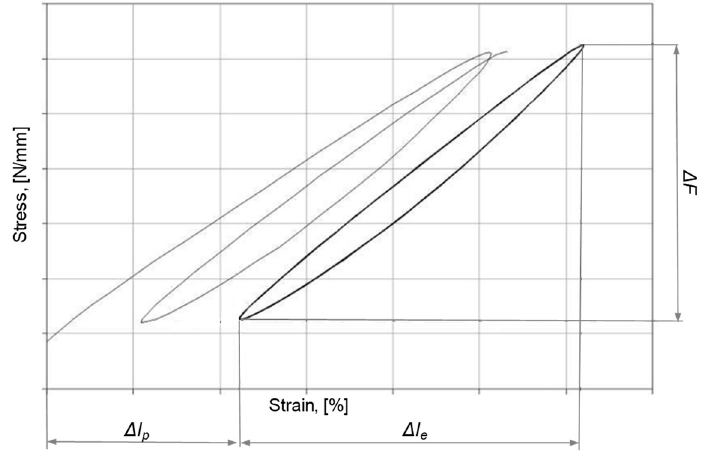
Figure 11. The 1st and the 200th hysteresis loop for a belt specimen.